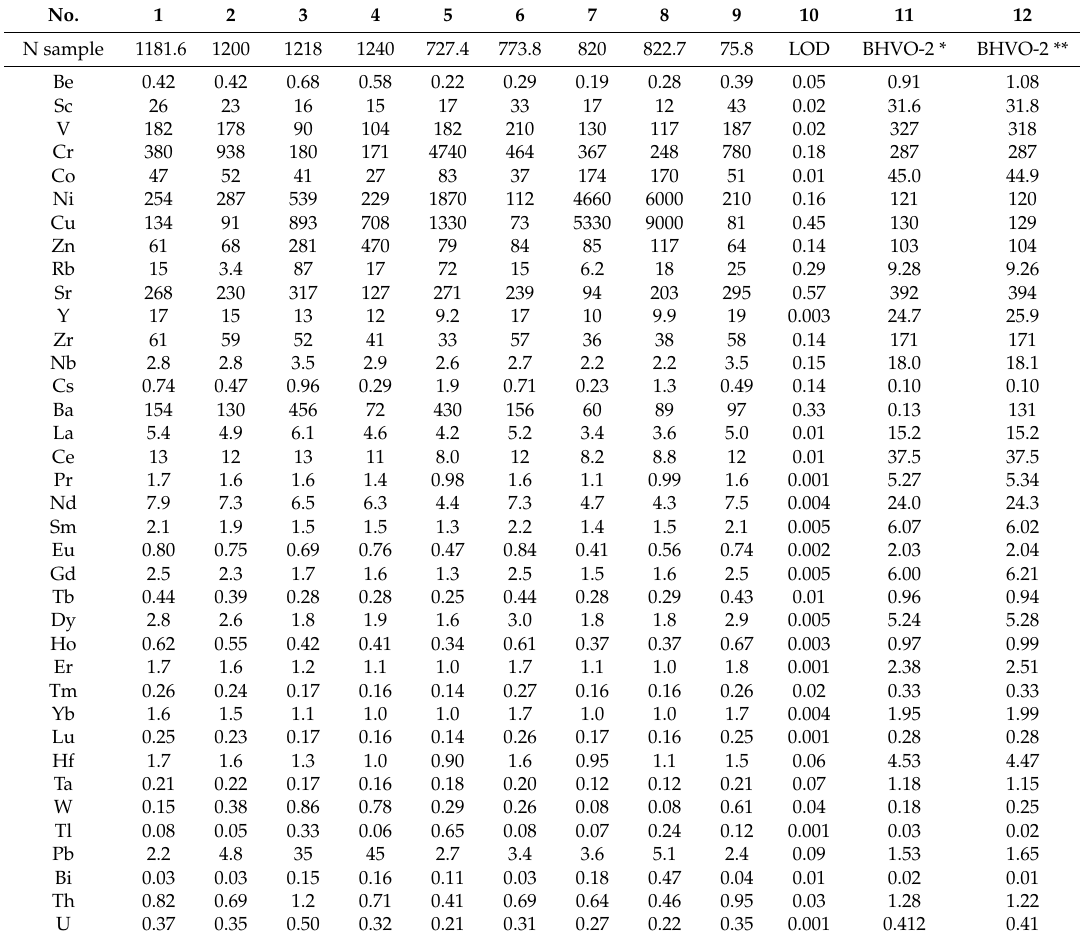
Table 2. Rare elements in rocks of the Talnakh intrusion,